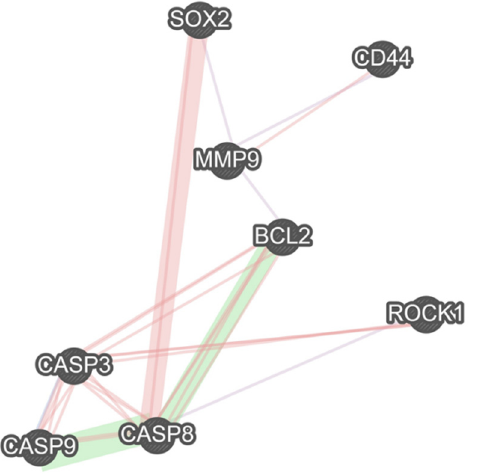
Figure 8. There are multiple remarkable associations between studied stemness-related, migration- related, and apoptosis-related genes. The purple links show the gene co-expression, the pink ones illustrate the physical interactions between the genes, and the green links show the genetic interactions.